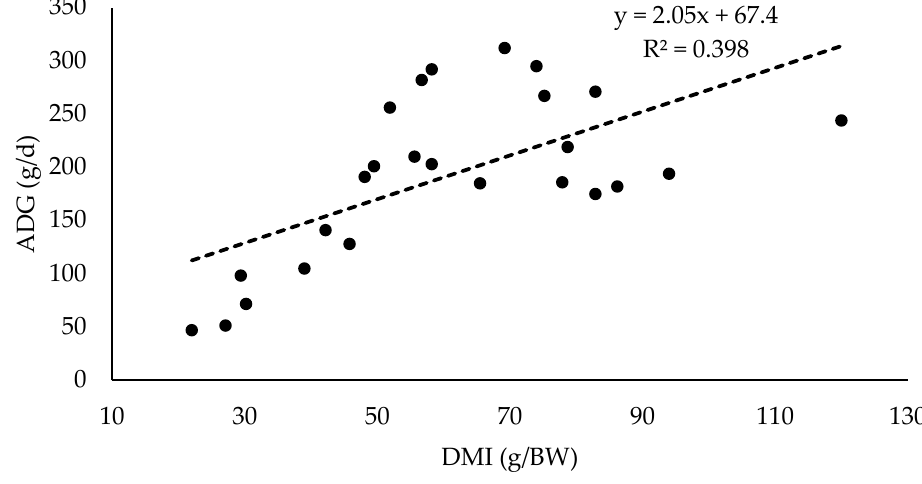
Figure 1. Relationship between dry matter intake (DMI; g / kg BW) and average daily gain (ADG; g / day) in lambs fed only fresh forage.